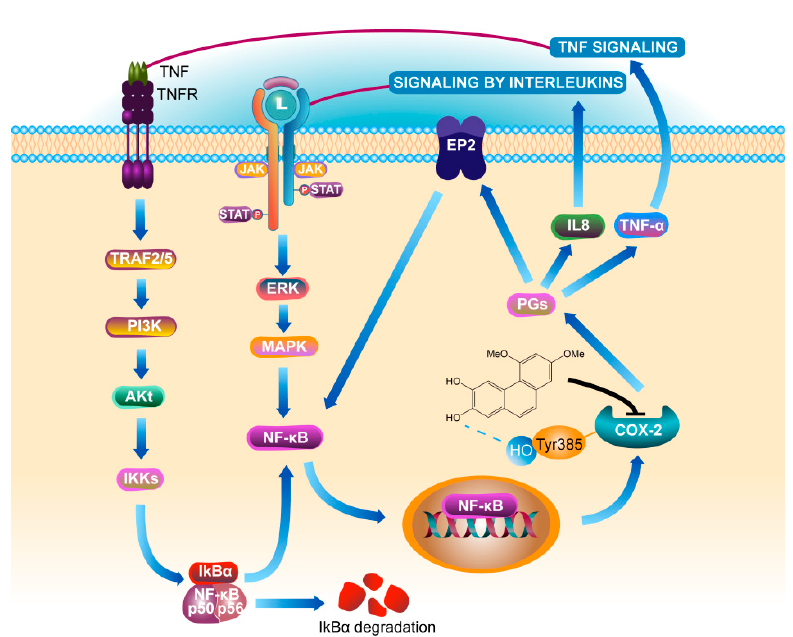
Figure 8. Mechanism of PC4 treating ulcerative colitis by inhibiting COX-2. Definitions of the ab- breviations in this figure are below: tumor necrosis factor receptor (TNFR), tumor necrosis factor receptor-associated factors (TRAF), phosphatidylinositol-3-kinase (PI3K), protein kinase B alpha (namely Akt), nuclear factor kappa-B inhibitor alpha (IkB α ), nuclear factor kappa-B (NF- κ B), in- terleukin 8 (IL8), Janus kinase (JAK), signal transducer and activator of transcription (STAT), extracellular signal-regulated kinase (ERK), mitogen-activated protein kinase (MAPK), cyclooxygenase-2 (COX-2), prostaglandins (PGs), E-series of prostaglandin receptors type 2 (EP2), tumor necrosis factor- α (TNF- α ).